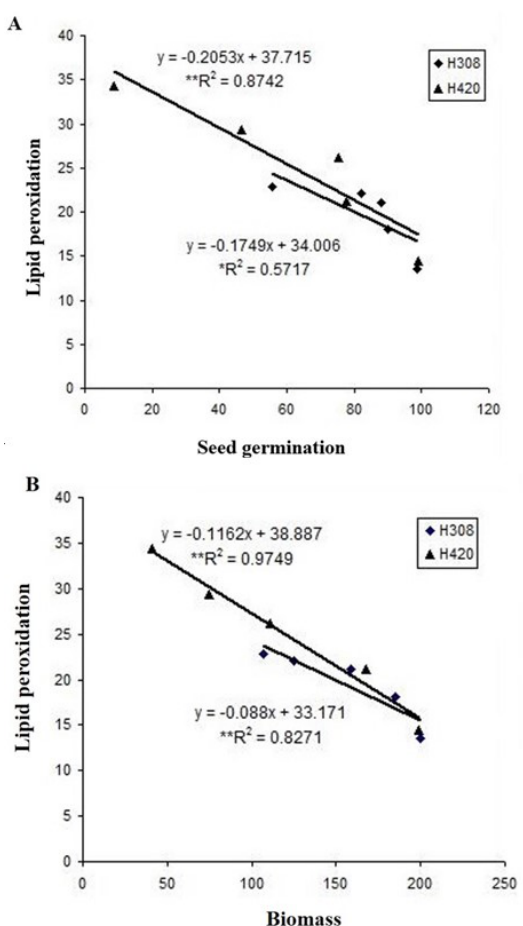
Fig 3. The correlations between lipid peroxidation with seed germination (A) or biomass (B) in two canola genotypes (H308, H420). **, * means significant at P<0.01 and P<0.05, respectively.